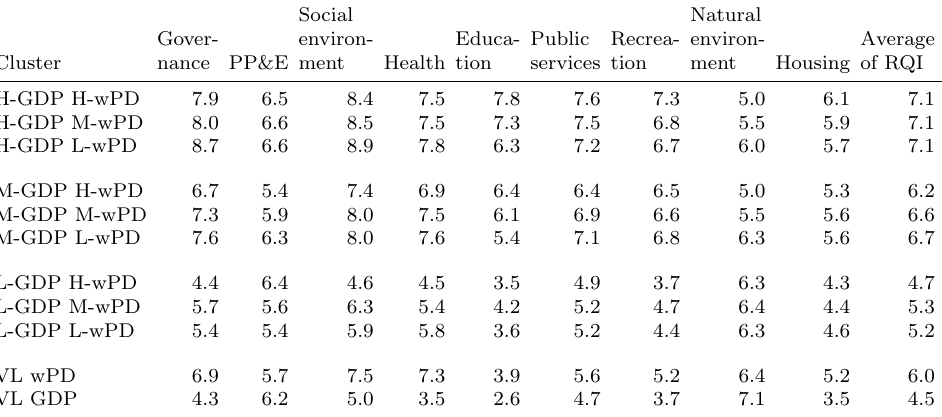
Table 1: Characteristics of the 11 clusters of European NUTS2-regions Social Natural Gover- Educa- Public Recrea- environ- Average Cluster services tion